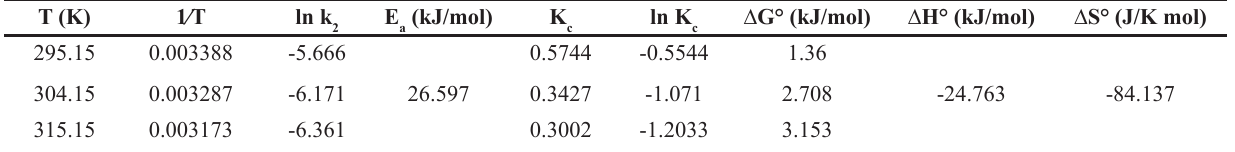
Fig. 4. Plot of lnKc vs. 1⁄T for estimation of thermodynamic parameter. Table 6. Thermodynamic parameters calculated with the pseudo-second-order rate